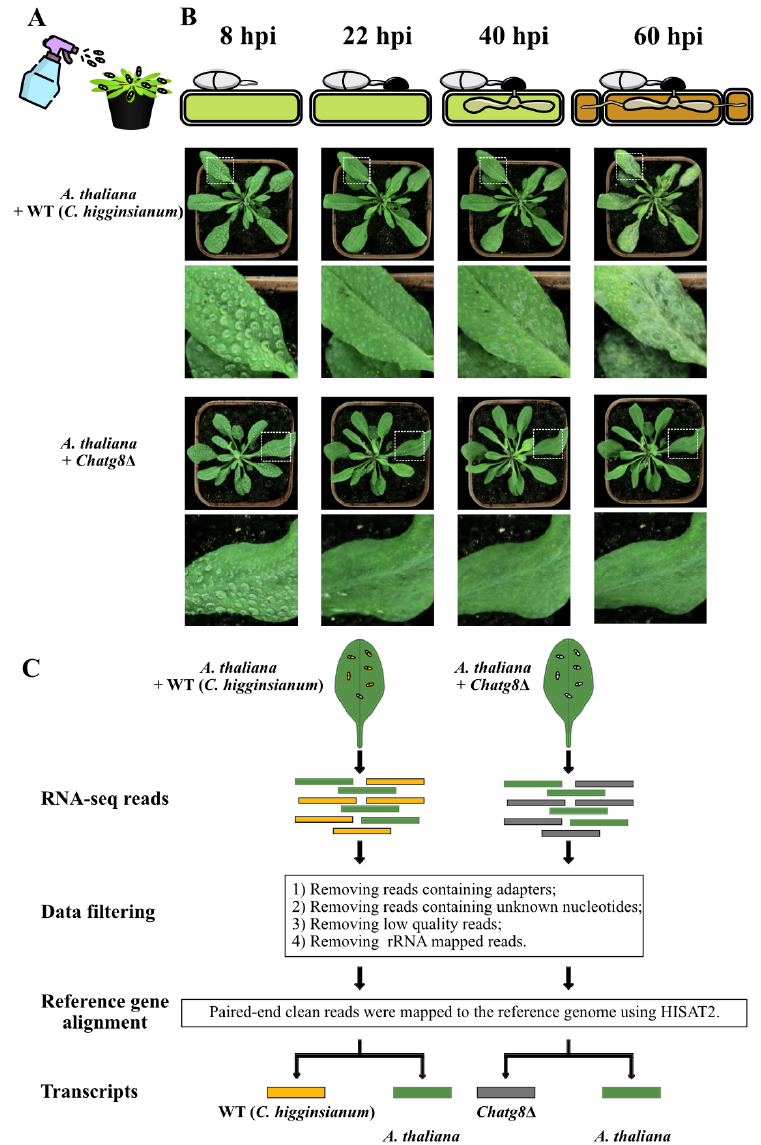
Figure 1. Schematic overview of dual RNA-seq analysis process. ( A ) Schematic diagram of inoculation. ( B ) Schematic illustration of the four developmental stages of C. higginsianum and the appearance of A. thaliana upon spray-inoculation with ChWT and Chatg8 ∆ conidial suspensions. In the top part of schematic diagram, the green rectangles indicate living plant cells and brown ones indicate dead plant cells. hpi is hours post-inoculation. The middle image shows A. thaliana upon spray-inoculation with ChWT strain at 8, 22, 40, and 60 hpi. The bottom image shows A. thaliana upon spray-inoculation with Chatg8Δ strain at 8, 22, 40, and 60 hpi. The white dashed box indicates the enlarged leaf area below. ( C ) Flow chart represents the dual RNA-seq analysis of the mixed transcriptome obtained from A. thaliana leaves infected with ChWT strains and A. thaliana leaves infected with Chatg8 Δ strains.